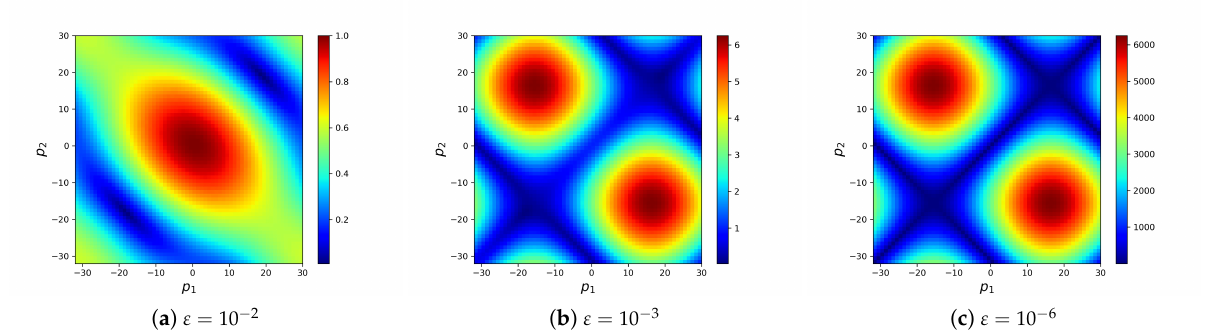
Figure 8. Distribution of convergence factor for weighted Jacobi method ( ω = 4/5) when solving the system corresponding to ε = 10 − 2 ,10 − 3 ,10 − 6 .